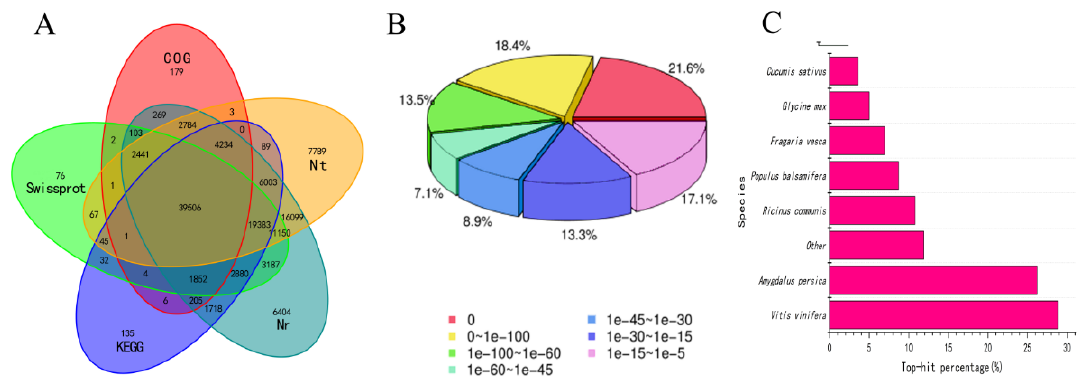
Figure 2. Characteristics of the homology search for Chinese chestnut kernel unigenes. ( A ) Venn diagram of the number of unigenes annotated by BLASTx with an E-value threshold of 10 − 5 against protein databases. The numbers in the circles indicate the numbers of unigenes annotated by single or multiple databases. ( B ) E-value distribution of the top BLASTx hits against the NR database for each unigene. ( C ) Number and percentage of unigenes matching the top eight species using BLASTx in the NR database.